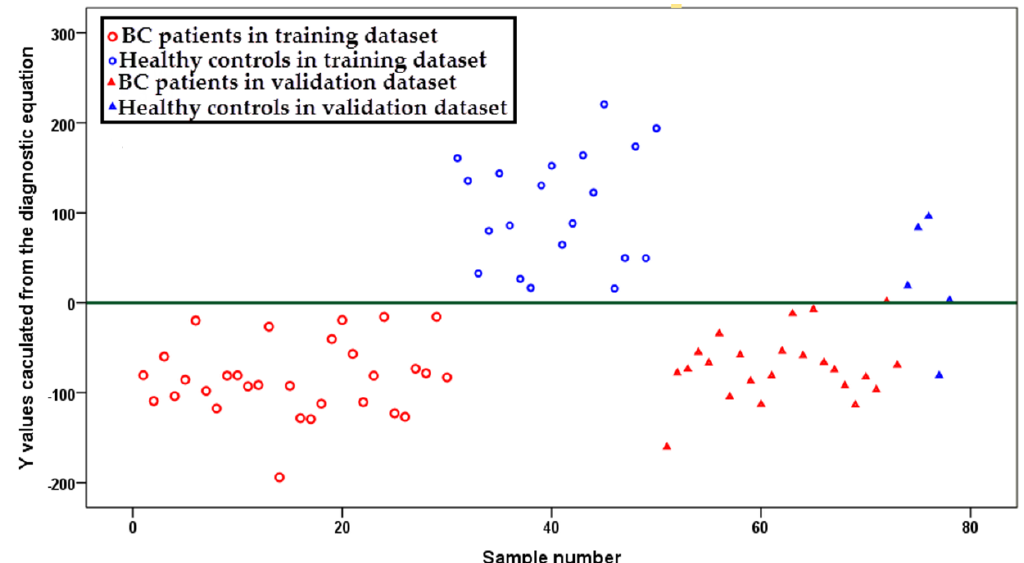
Figure 3. Scatter plot for y -values calculated from an established breast cancer versus healthy control diagnostic equation. Samples in blue represent healthy controls, while samples in red represent breast cancer patients. Samples represented by circles indicate the training samples and triangles for the validation